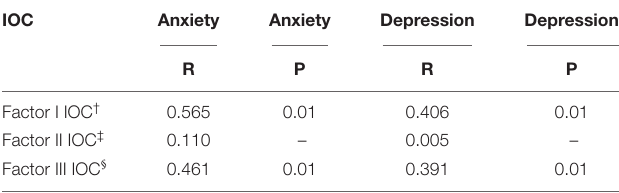
TABLE 5 | Correlations of anxiety and depression with IOC.